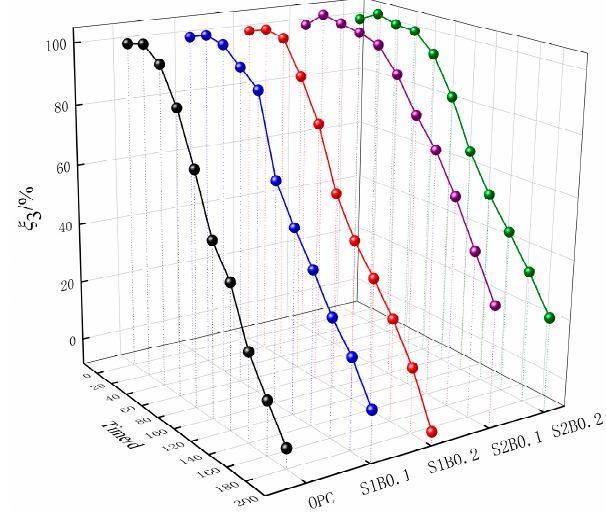
Figure 5. Time variation curve of relative dynamic elastic modulus evaluation parameters.